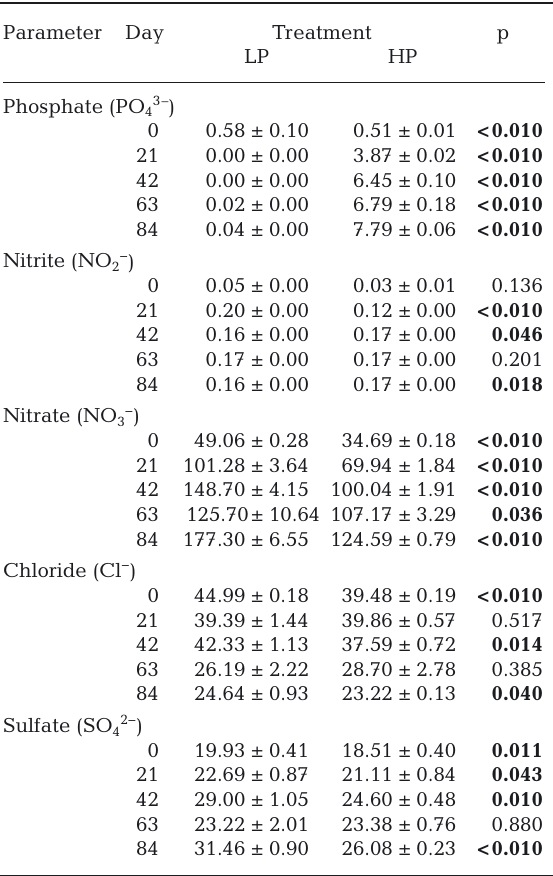
fed the HP diet than the LP diet for most of the sam- pling events (Table 5). The geosmin concentrations of trout fillets were higher in fish fed the HP diet versus the LP diet. A pairwise comparison showed significantly higher geosmin levels in fish fillet with fish fed the HP diet (3.13 µg kg −1 and 2.42 µg kg −1 ) than fish fed the LP diet (1.29 µg kg −1 and 1.36 µg kg −1 ) for Weeks 3